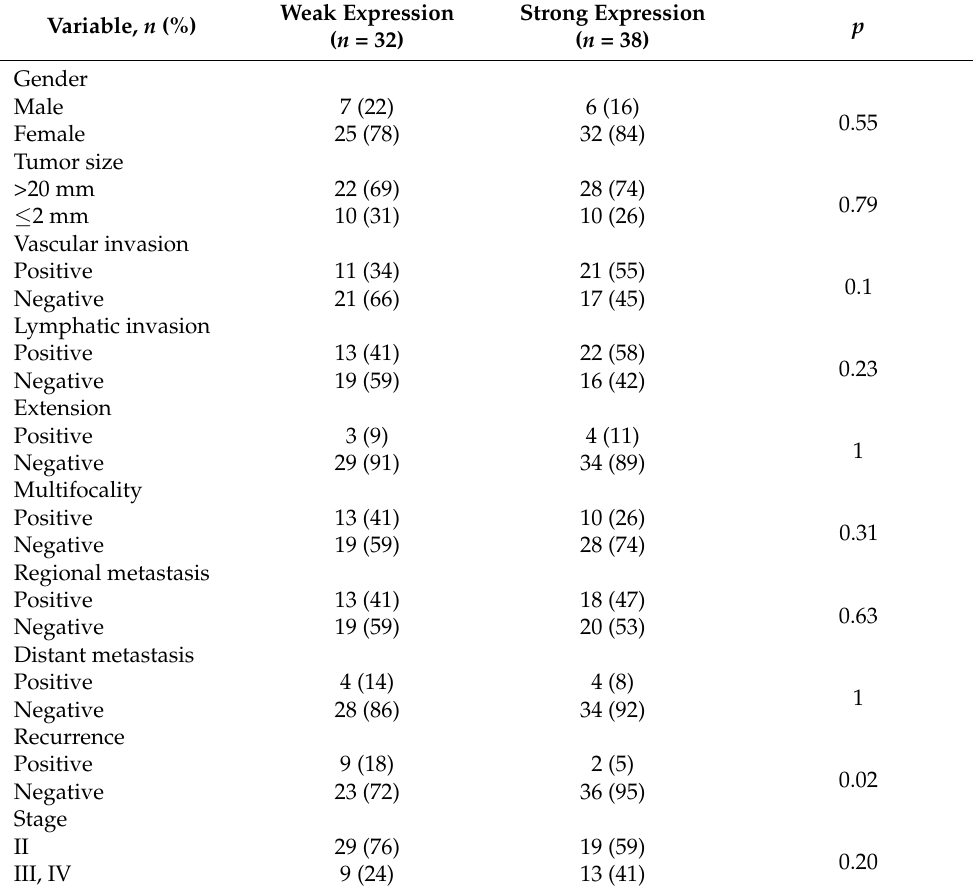
Table 2. Detailed correlations between the PRDX4 expression and clinicopathological